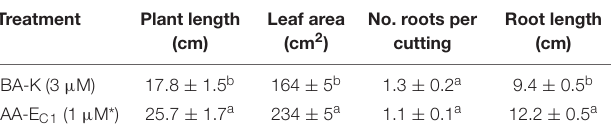
TABLE 2 | Effect of different auxin treatments on plant length, leaf area, number of roots per cutting, and root length of hazelnut cv. “Fertile de Coutard.”